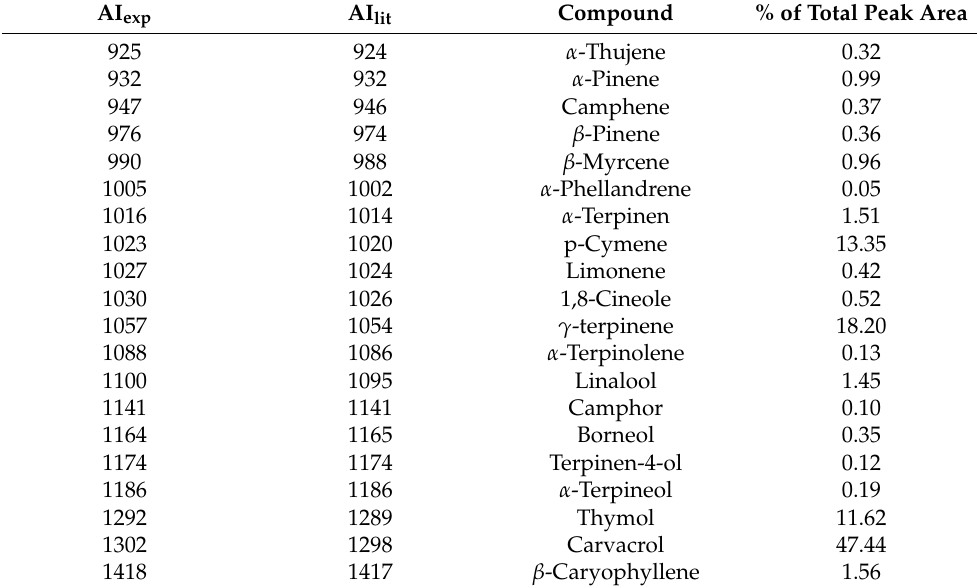
Table 1. The main constituents (% of total peak area) of HerbELICO essential oil mixture determined by GC-MS.